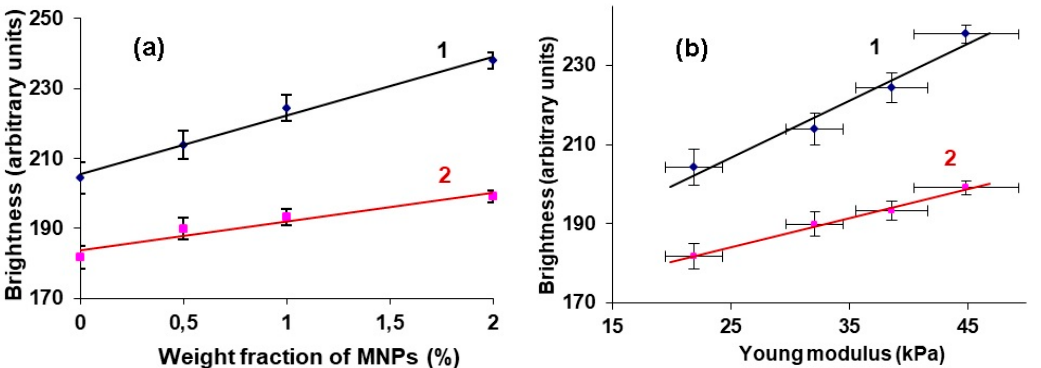
Figure 5. Examples of ferrogels samples visualization at the bottom of water cuvette ( a ) and inside a silicone tube filled with water ( b ). The distance from sensor to objects is about 20 mm. 1—soft pad (a) and wall of silicone tube (b); 2—water in cuvette (a) and in tube (b); 3—upper boundary of gel / water; 4—gel body.